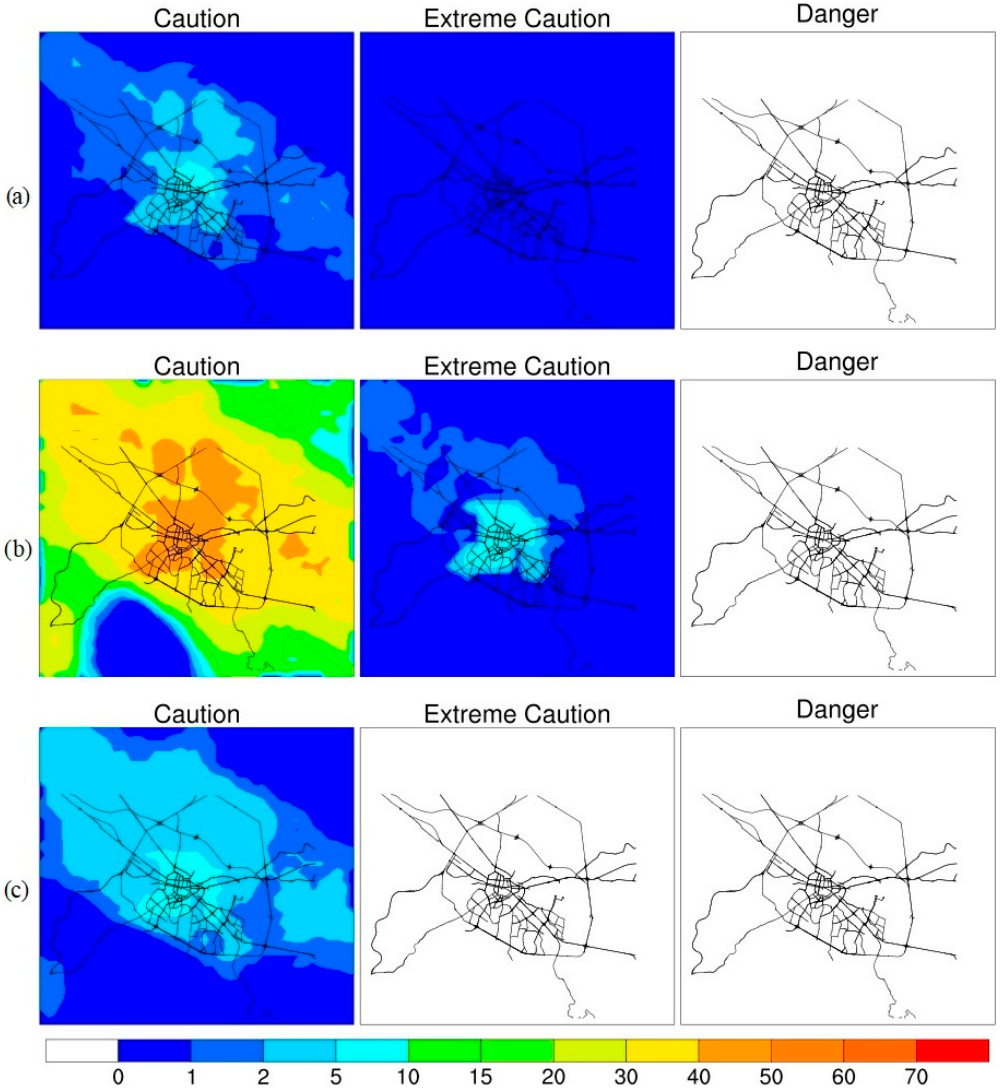
Figure 8. Frequency (in %) for ( a ) spring, ( b ) summer, and ( c ) autumn of the Heat index categories “Caution” (first column), “Extreme caution” (second column), and “Danger” (third column) in the Sofia region at 12 UTC during the spring (first row), summer (second row), and autumn (third row).